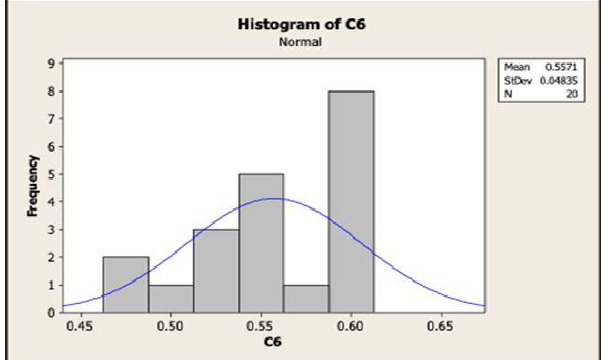
Fig.6: Normal distribution at confidence level 95% for Anti-body titer Serum samples) (IBD) by